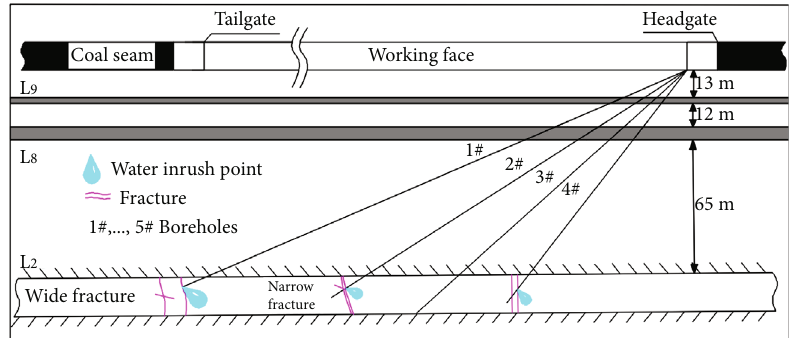
Figure 1: Characteristics of aquifers under coal seams and spatial layout of grouting